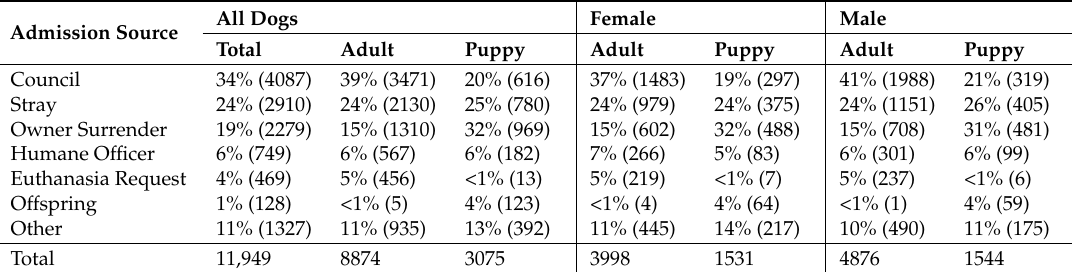
Table 1. Summary of age group (adult > 6 months and puppy ≤ 6 months), sex and admission source of 11,949 dogs processed through RSPCA Queensland shelters in